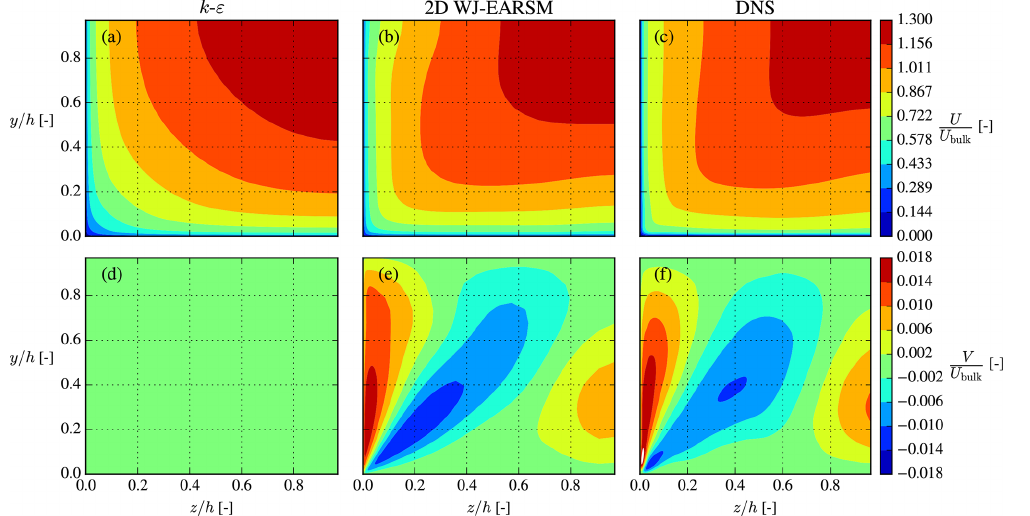
Figure 8. Streamwise (a–c) and vertical (d–f) velocity contours in the lower left quadrant of the square duct. Normalized by the bulk velocity, (cid:82) U d A . U bulk = 1 A